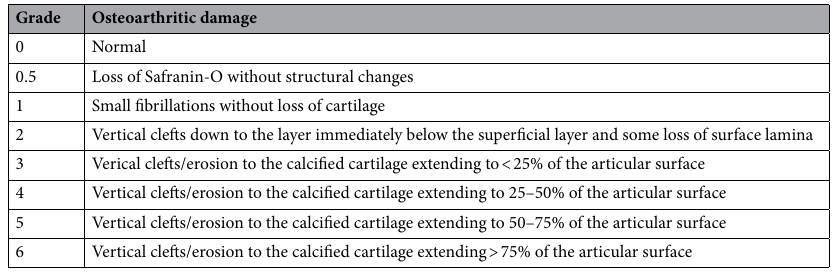
Table 1. OARSI histological assessments of osteoarthritis.